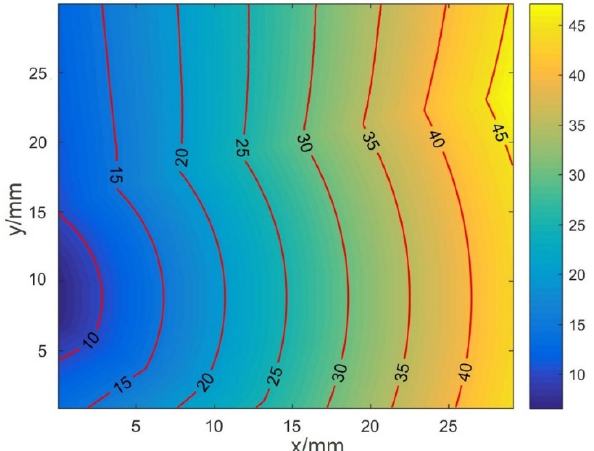
Figure 8. Distribution of the maximum driving distance ( D ). ( a ) Rectangular design domain ( Lx × Ly ). ( b ) Meshing of the design domain.